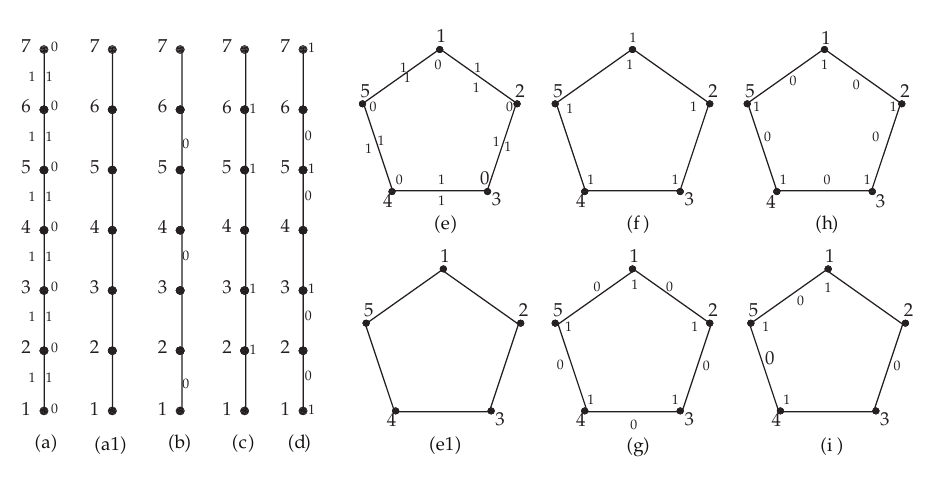
Figure 2: Some weighted